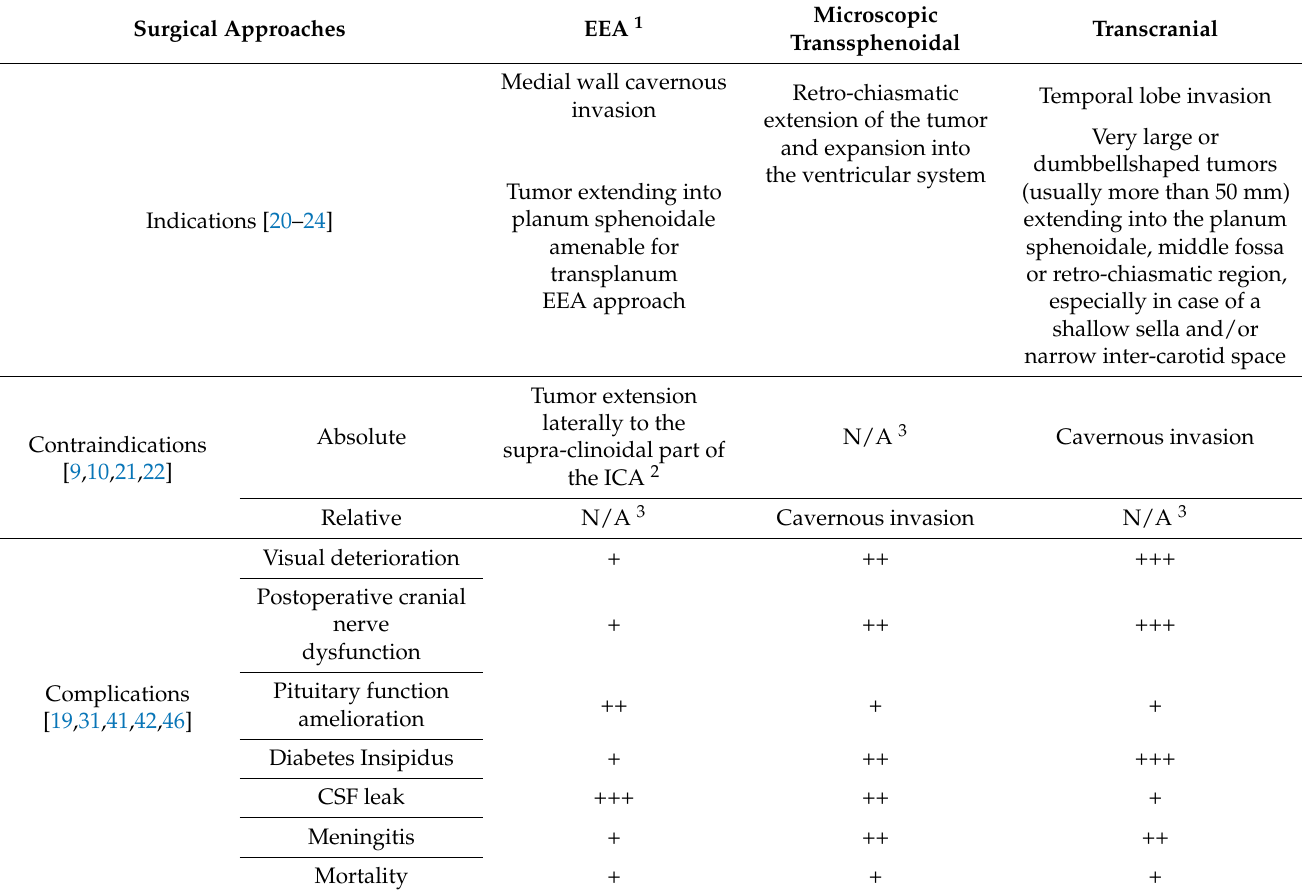
Table 2. Surgical indications, technical limitations, and complications of various approaches to GPAs. Surgical